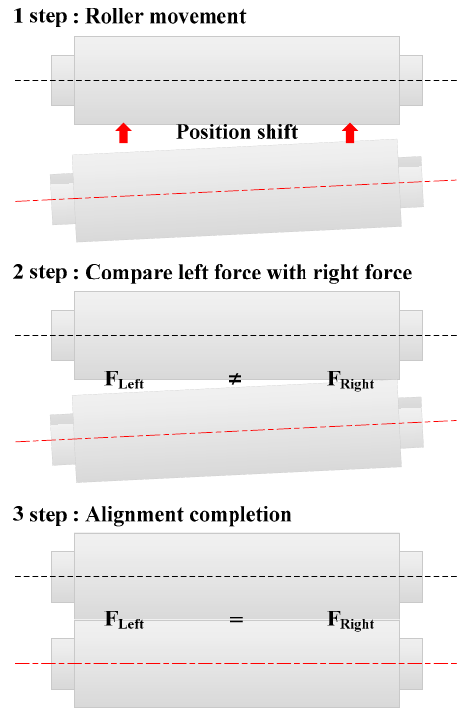
Figure 3. Basic concept of automatic alignment of roller.